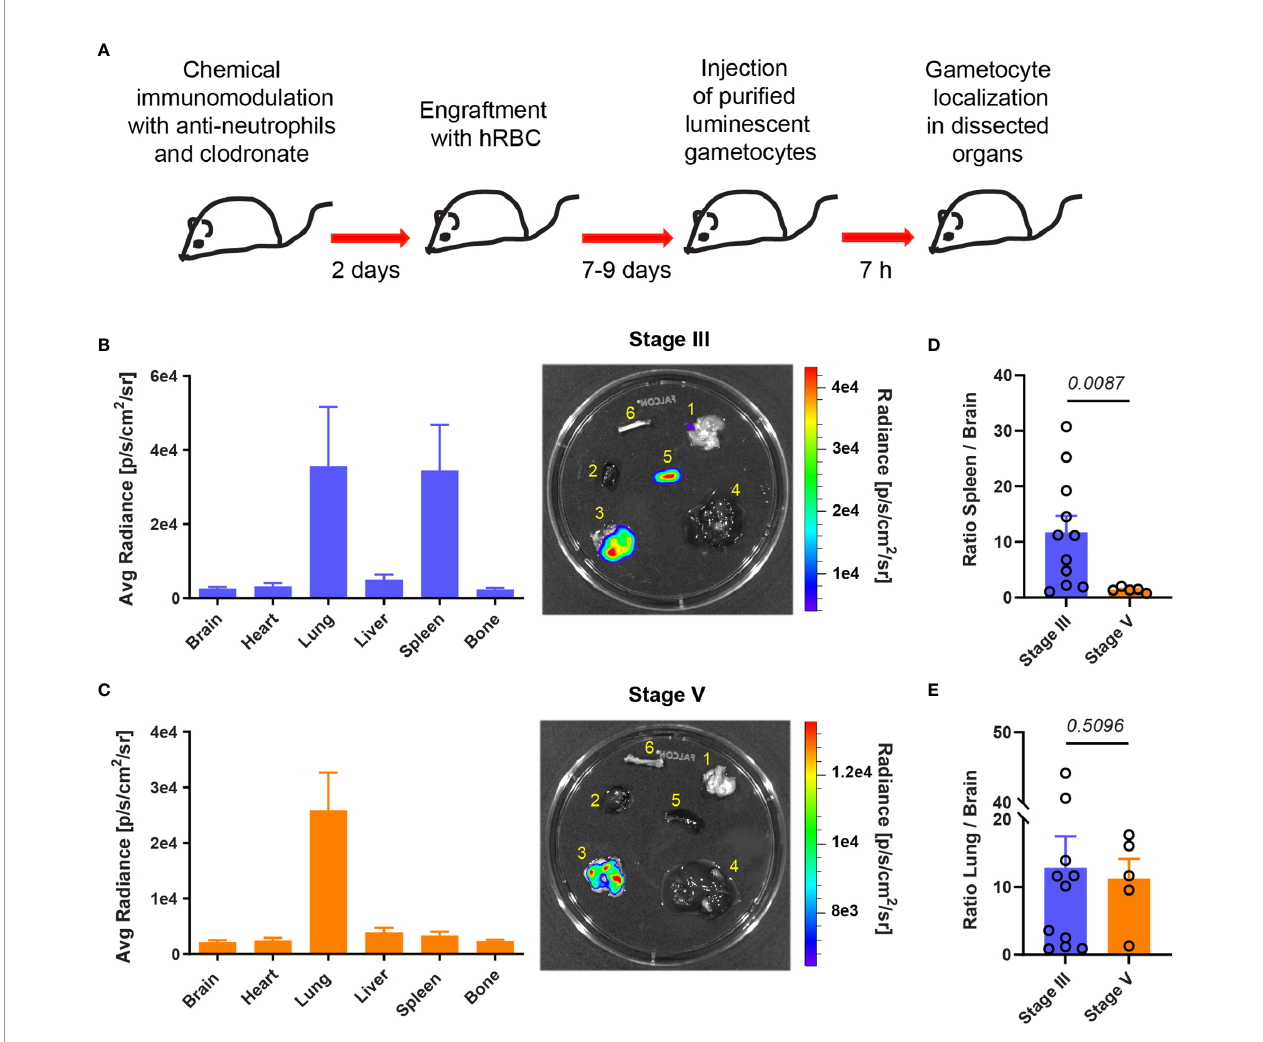
FIGURE 2 | Stiff immature GIE are retained in the spleen. (A) Schematic of experimental procedure for immunomodulation treatment and hRBC engraftment of NSG mice before injection with luciferase-expressing immature (stage III) and mature (stage V) gametocytes. GIE distribution was quanti fi ed 7 hpi by measuring luciferase activity in dissected organs. (B, C) Left: Quanti fi cation of GIE distribution visualized by measuring average radiance (p/s/cm 2 /s) in dissected organs (B: stage III n=11 mice from 4 independent experiments; C: stage V n=5 mice from 2 independent experiments). Right: Representative images of luminescent signals in dissected organs (1, brain; 2, heart; 3, lungs; 4, liver; 5, spleen; and 6, bone) and heat map of radiance (p/s/cm 2 /sr). Rainbow shows the relative level of luciferase activity. Note that the scale of radiance can be different within separate illustration. (D, E) Quanti fi cation of luciferase activity calculated as the ratio of radiance in spleen and brain (D) or in lung and brain (E) . Circles indicate the number of mice from four independent experiments for stage III GIE and two independents experiments for stage V GIE. p indicates the statistical signi fi cance determined using a Mann Whitney test. Error bars show the